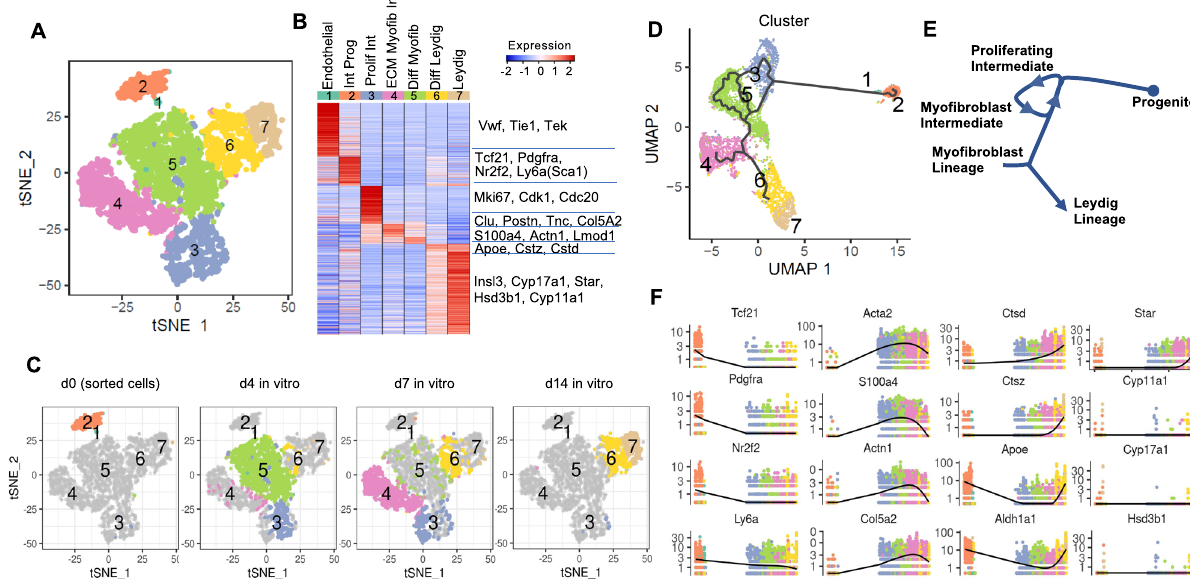
Fig. 3 scRNA-seq differentiation trajectory of in vitro derived Leydig cells. A Single-cell RNA-seq time course analysis of in vitro Leydig differentiation (days 0, 4, 7, and 14) identi fi es seven clusters, as visualized in t-SNE space. Note: n = 1 replicate per timepoint, but in vitro differentiation was successfully completed 8 times in prior experiments. B Heatmap of differentially expressed markers across the seven cluster centroids. C Visualization of the contribution of each individual time point at day 0, 4, 7, or 14 to the 7 clusters in t-SNE space. D Pseudotime ordering of cells from the 4 time points (days 0, 4, 7, and 14) by Monocle3 in UMAP space, colored by 7 clusters. E Schematic annotation of differentiation trajectory as de fi ned by Monocle. F Expression pro fi les of selected markers across the differentiation